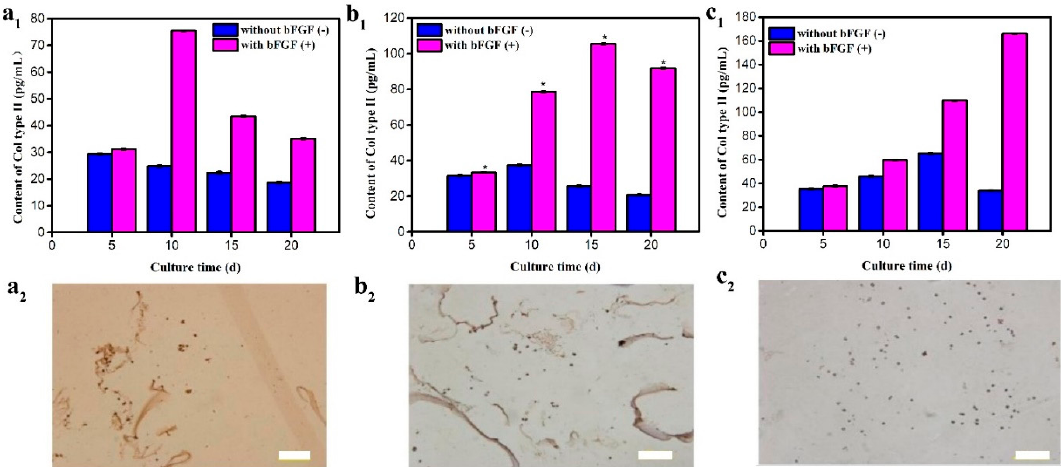
Figure 6. Type II collagen content detection under different culture conditions: ( a 1 ) Static, ( b 1 ) shaking, and ( c 1 ) RCCS (* p < 0.05); Immunohistochemistry staining of artificial C5.18 cells with bFGF under different culture conditions: ( a 2 ) Static, ( b 2 ) shaking, and ( c 2 ) RCCS. Bar is 100 μ m.